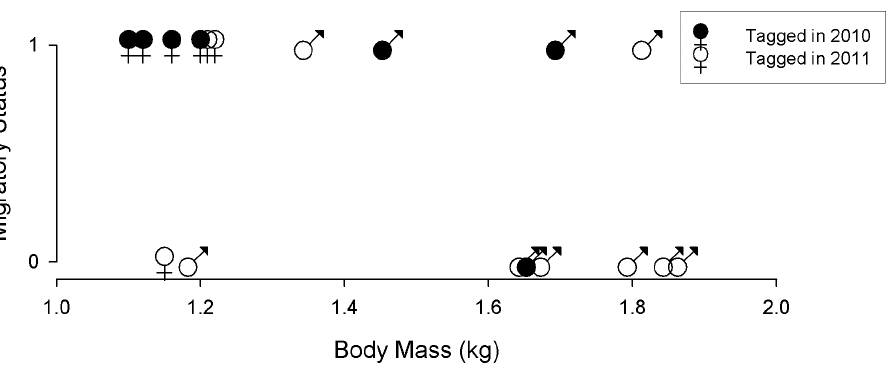
Figure 3. Relationship of body mass (kg) by sex to migratory status, where ‘0’ is sedentary and ‘1’ is migratory. Filled symbols represent birds tagged in 2010 and open symbols show birds tagged in